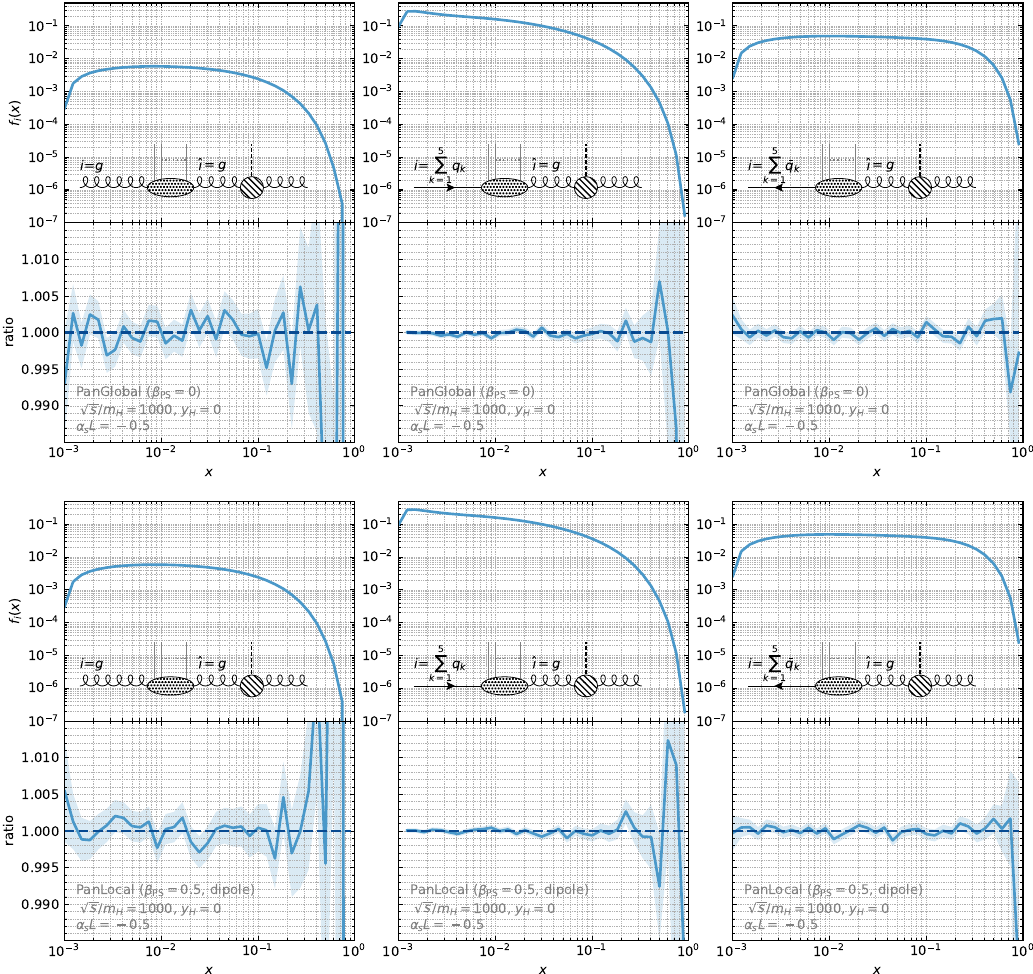
Figure 2. Same as figure 1 but with the gg → H